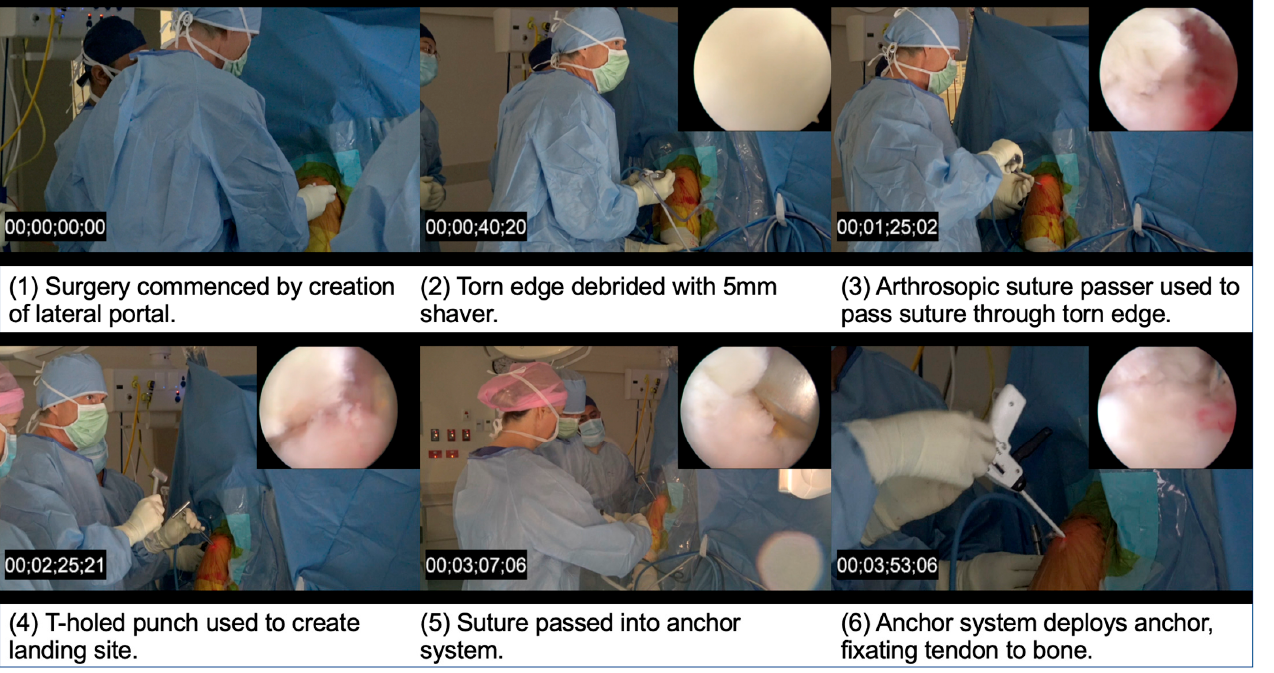
Figure 5. Video of 4-min arthroscopic rotator cuff repair. Adapted from “Arthroscopic